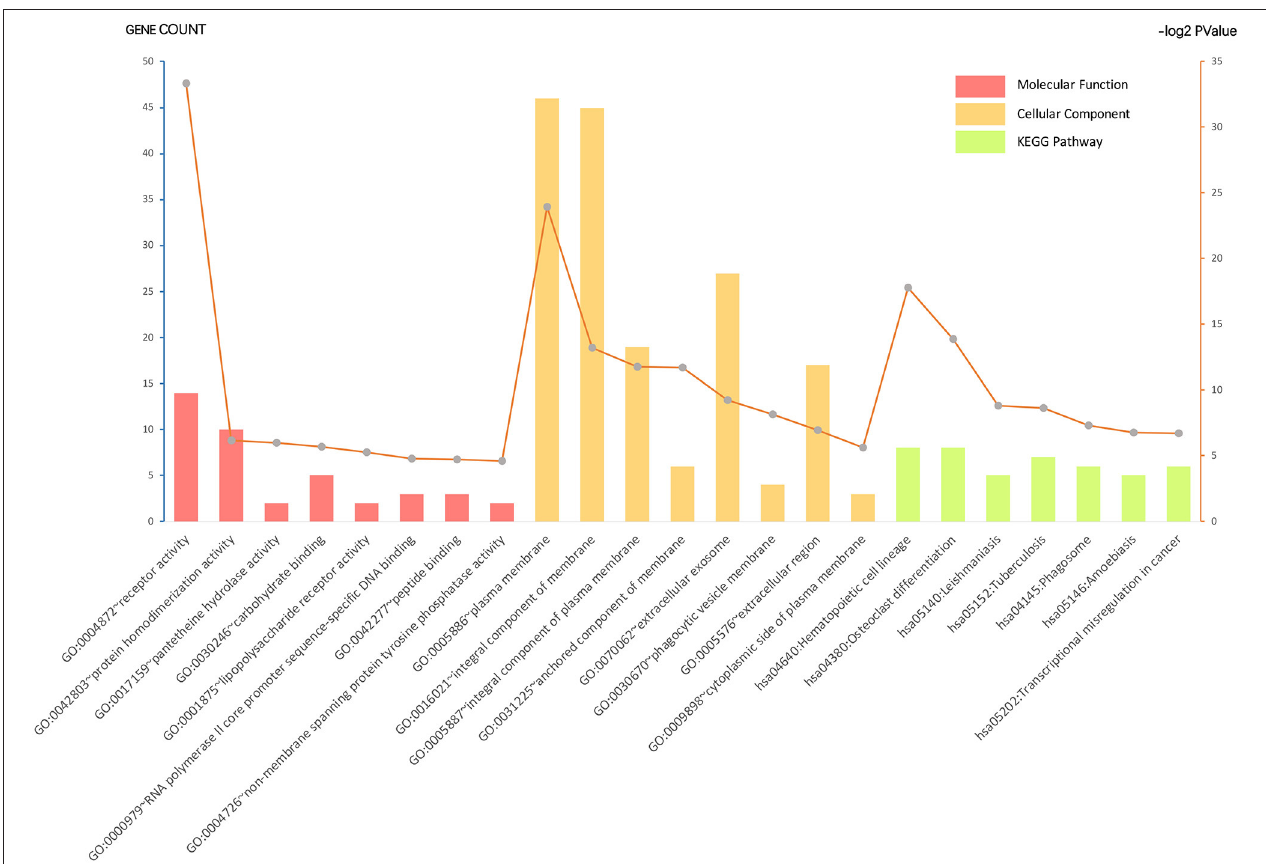
FIGURE 2 | Gene ontology (GO) analysis and significant enrichment of the DEGs. GO analysis classified selected genes into the cellular component (CC), molecular function (MF), and KEGG pathway group, ranking significant enriched GO terms of the DEGs. The vertical axis on the left and the bar plot represents the gene count per term, and the vertical axis on the right and the gray dots represent log2 p -value (please consult Supplementary Table S4 for details). A p < 0.05 was considered statistically